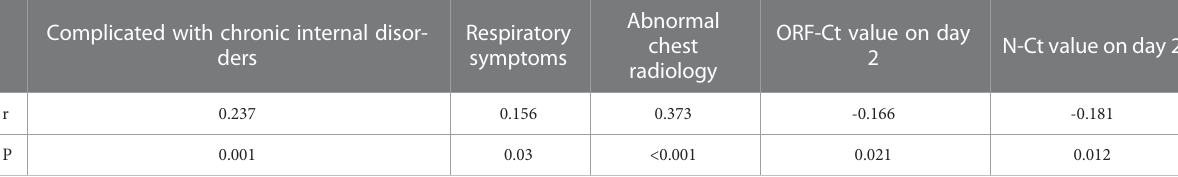
TABLE 4 Correlation the regression analysis of nucleic acid Ct value fl uctuation.